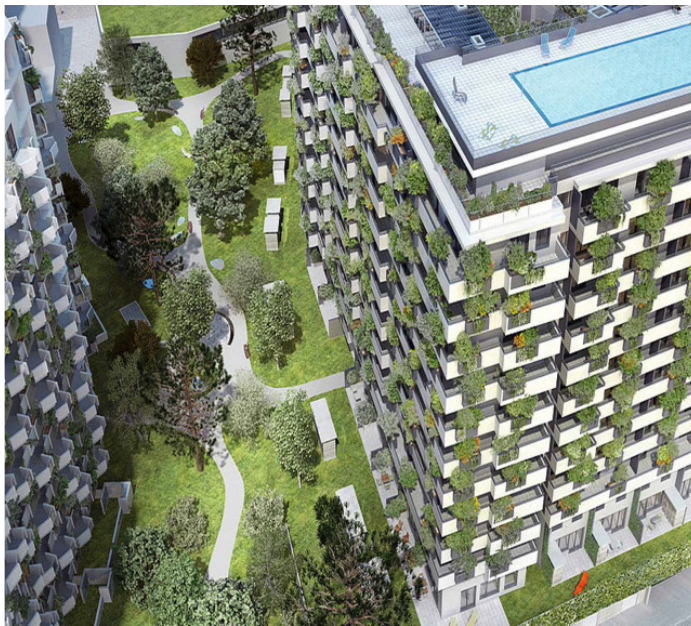
Figure 2. Biotope city in Vienna. Source: City of Vienna (2022).